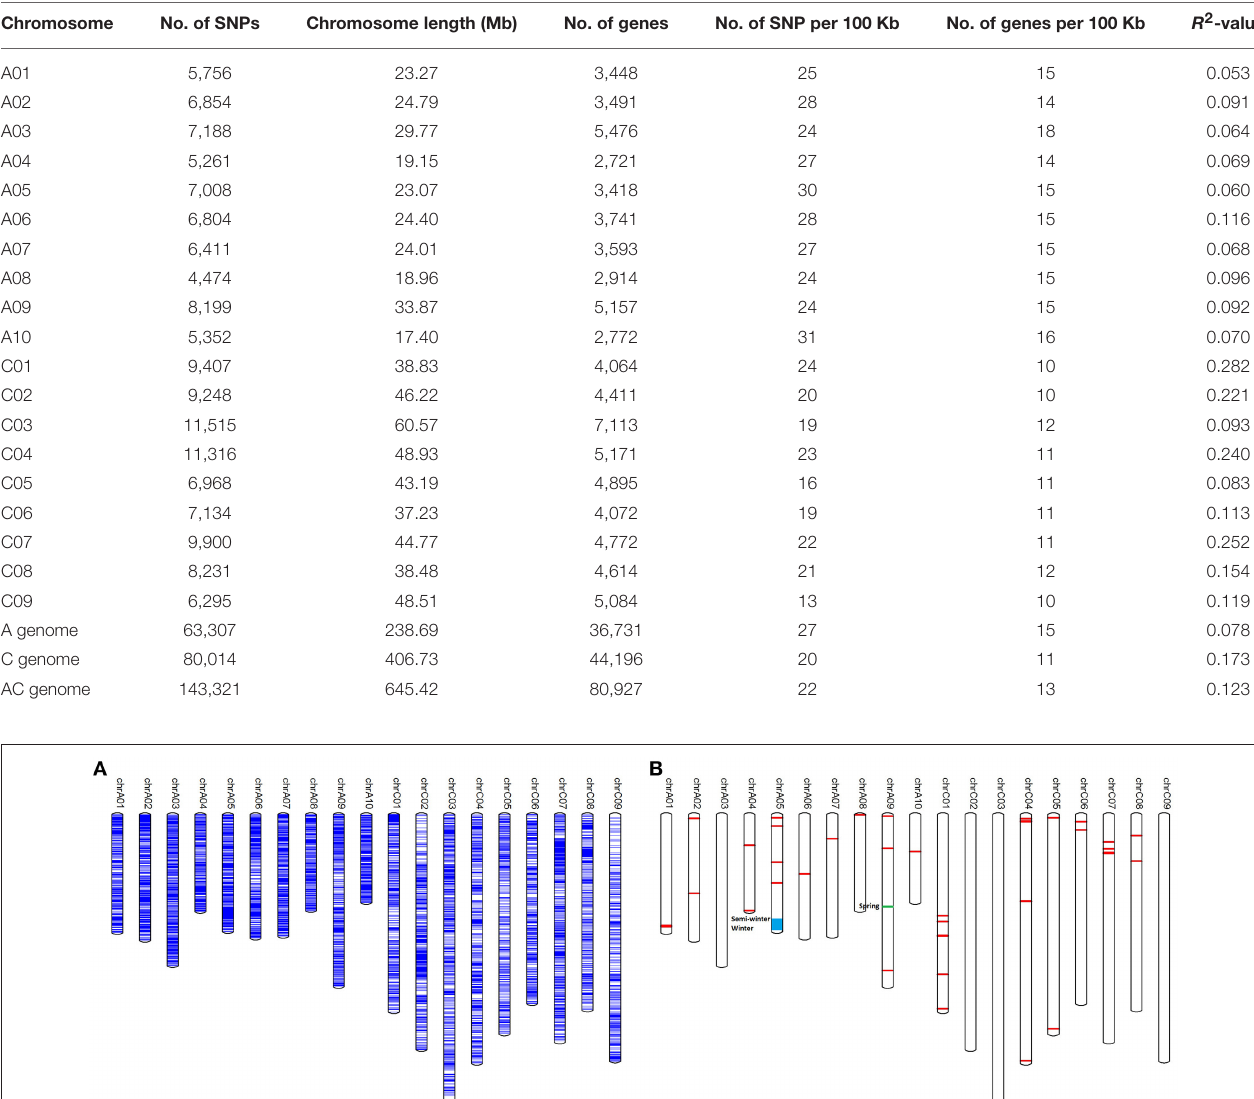
TABLE 2 | Distribution of SNPs and related genes in the B. napus genome.